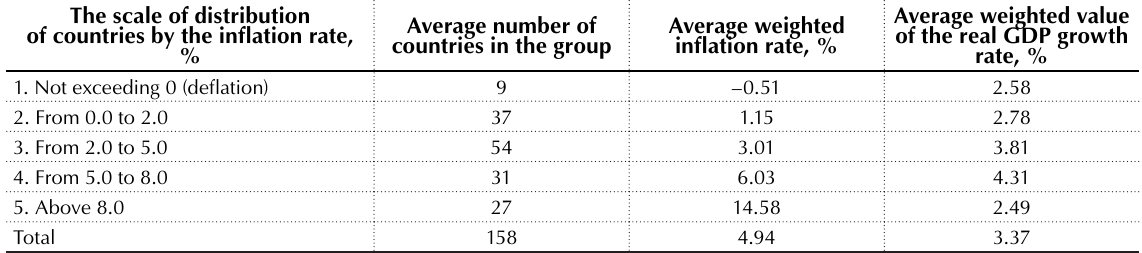
Table 1. Grouping the countries of the world based on the GDP growth rates dependence on the inflation rate in 2010–2017